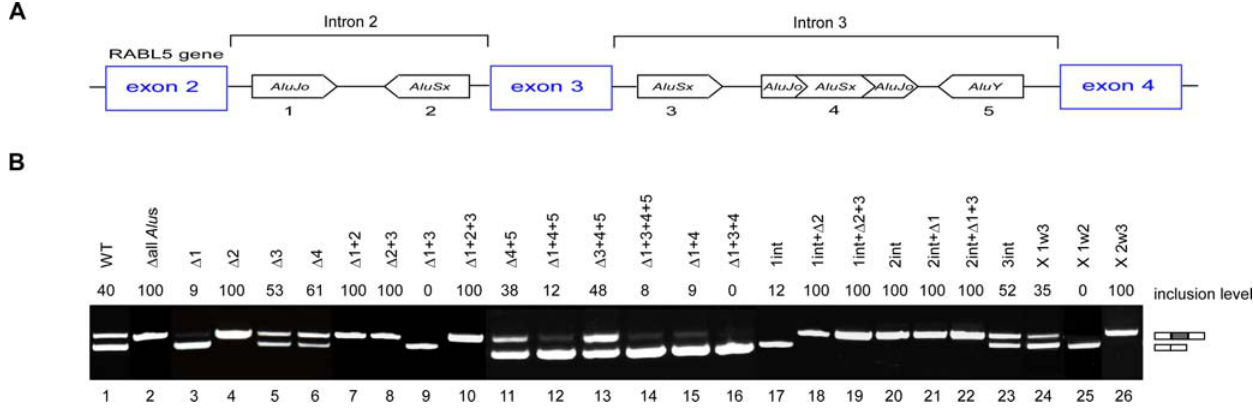
Figure 2. The effect of intronic Alu s on the splicing of a flanking exon. (A) Schematic illustration of the RABL5 minigene containing three exons and two introns. The intronic Alu s (1 through 5) are marked by boxes with a point indicating the orientation of the Alu relative to the pre- mRNA. Alu 4 is an Alu Sx inserted between the two arms of Alu Jo. (B) The indicated wild-type (wt) and mutant plasmids were transfected into 293T cells, total RNA was extracted, and splicing products were separated on a 2% agarose gel after RT-PCR analysis. Lane 1, splicing products of wt RABL5 minigene. Lanes 2–26, splicing products of the indicated mutants. The following abbreviations were used: D indicates deletion of the specified Alu element, X 1w3 indicates replacement of Alu 1 with Alu 3 (i.e., the sequence of Alu 3 was inserted instead of that of Alu 1 and in the same orientation as Alu 3), and 1int specifies replacement of the Alu 1 sequence with a non- Alu intronic fragment. The two mRNA isoforms are shown on the right. Numbers on top of the gel indicate percentage of exon inclusion as determined using ImageJ software. PCR products were sequenced.